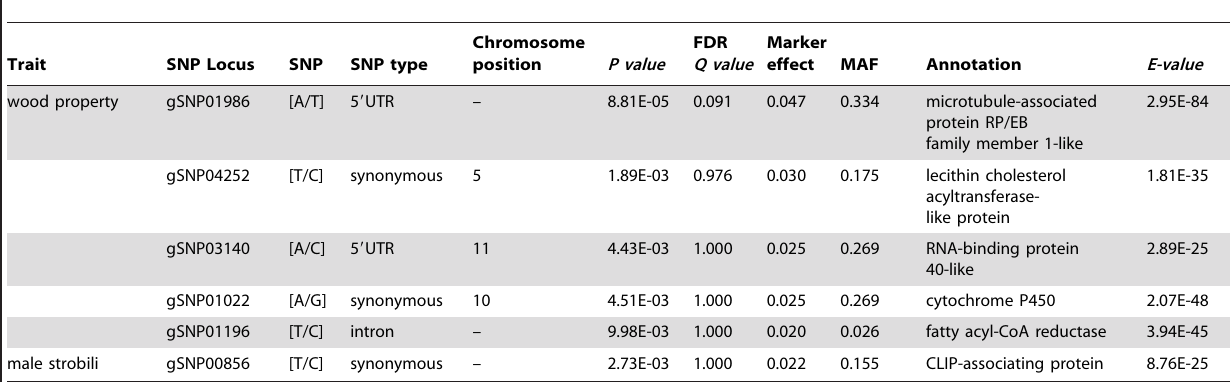
Table 3. SNP locus annotations and significance values for wood property and quantity of male strobili.